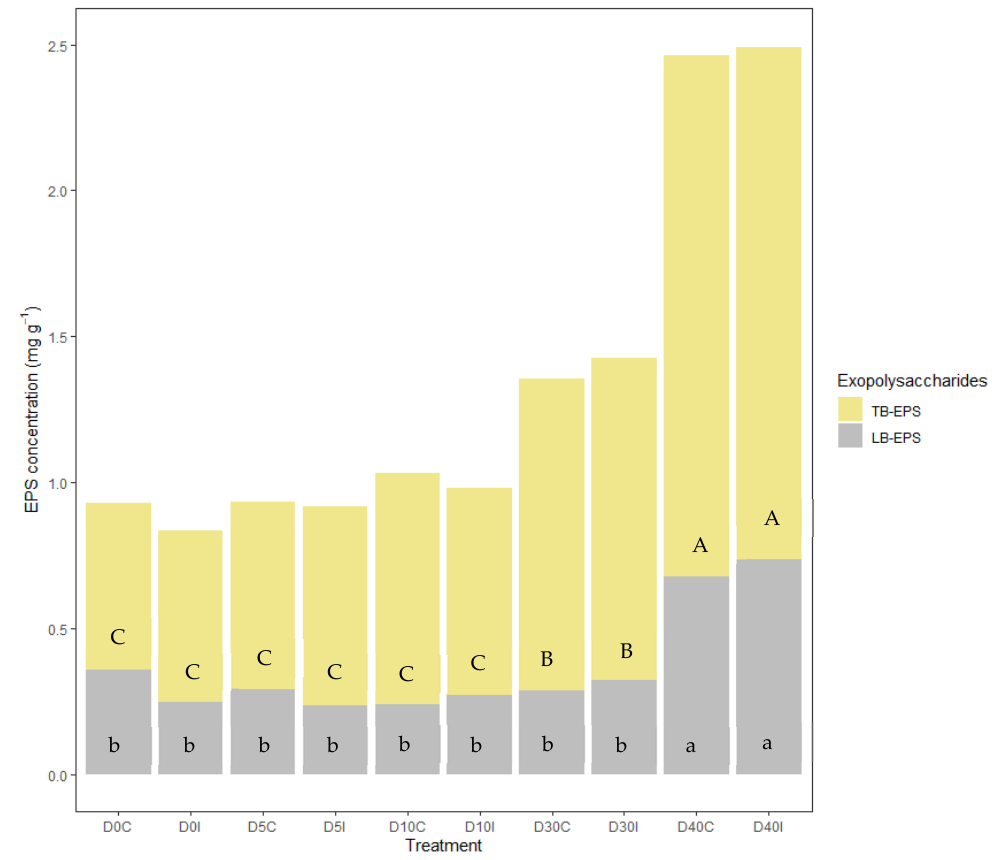
Figure 6. Exopolysaccharide content (mg EPS g − 1 soil) in the control (C) and inoculated (I) soils for the different SS doses (t ha − 1 ), after 4 months. Lowercase letters indicate significant differences in LB ‐ EPS content at the different SS doses, while capital letters indicate significant differences in TB ‐ EPS content at the different SS doses.